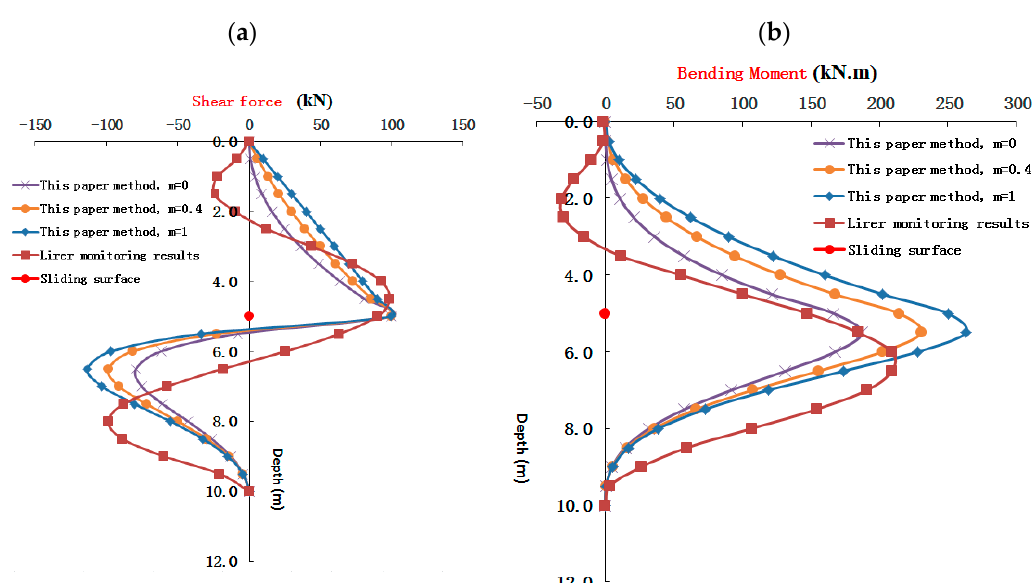
Figure 2. Comparison of monitoring results and our calculated values of internal forces for the bored pile under various driving force distribution coefficients: ( a ) shear force; and ( b ) bending moment.